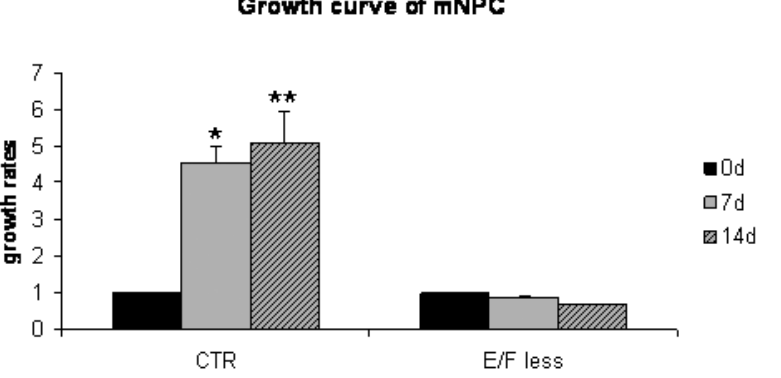
Fig. 2 – Analysis of mouse neurospheres growth during growth factor withdrawal. We found no significant increase in size during starvation of mNPC. In contrast, neurospheres from the CTR groups increased significantly in size during the experiment. After 7 days in culture, mNPC reach a plateau and they keep the same size until 21 days. Abbreviations: CTR – neurospheres submitted to regular conditions; E/F-less – neurospheres grown in absence of FGF-2 and EGF. Statistically significant differences in growth rates are represented by * (n = 3; P < 0 . 005).